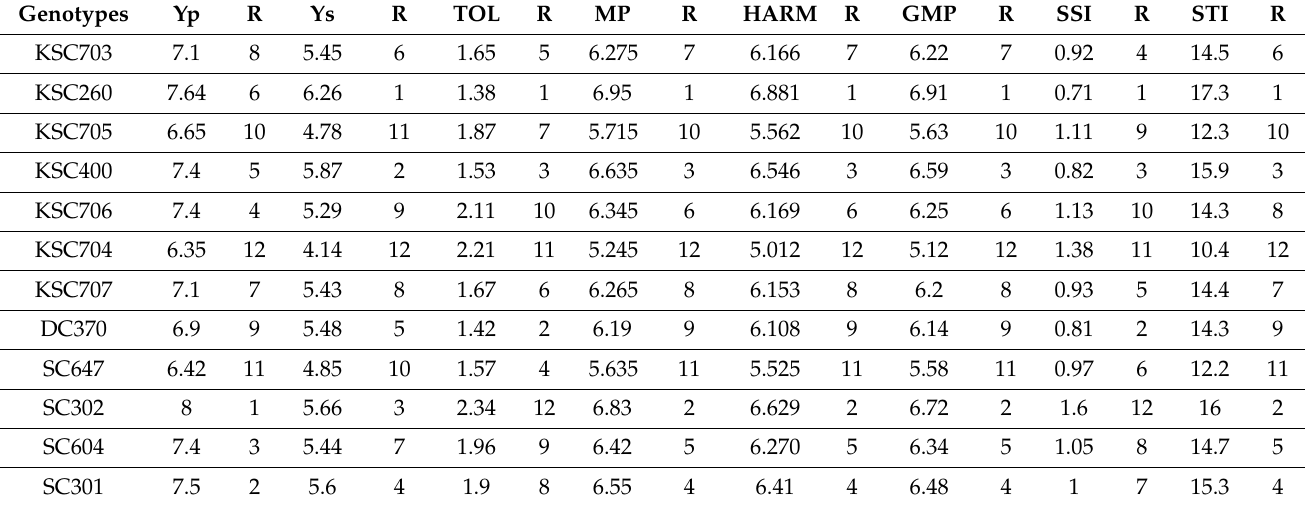
Table 4. Evaluation of hybrids evaluated in the test under stress conditions through drought-tolerance indices.